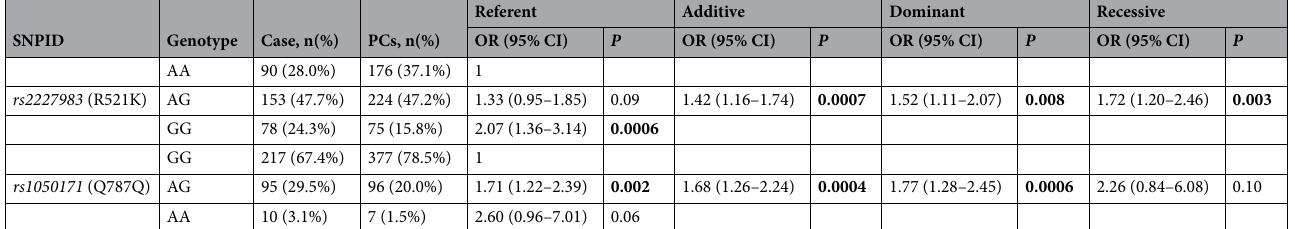
Table 4. Logistic analysis of rs2227983 and rs1050171 in EGFR with the risk of Glioma. Logistic regression analysis under referent, additive, dominant, and recessive models are used for calculating ORs and corresponding P-values for SNP controlling age and sex as covariates. The homozygotes of major allele were used as the referent group to the heterozygotes and homozygotes of the minor allele. Significant values are in bold. PC population control, OR odds ratio, CI confidence interval.